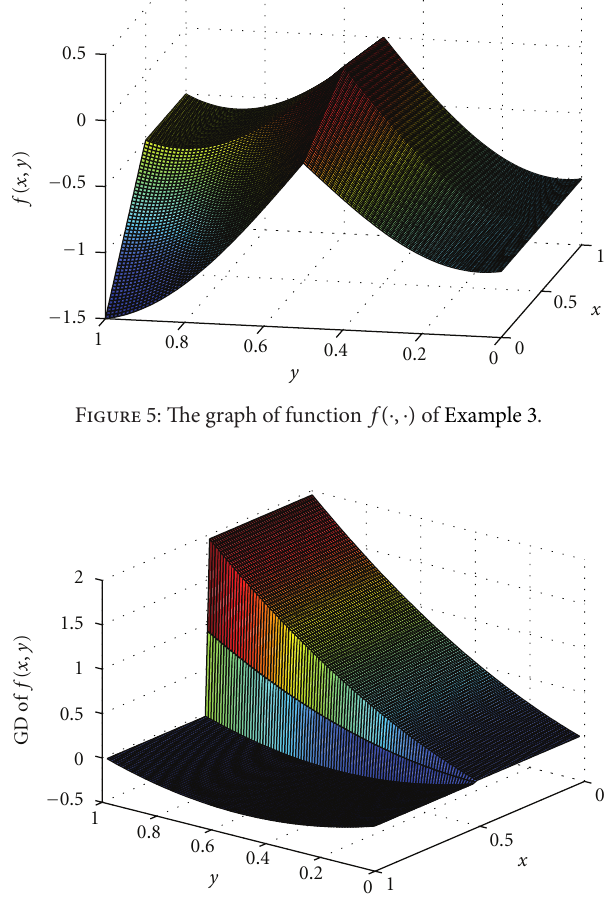
Figure 6: The graph of GD of 𝑓(⋅,⋅) with respect to 𝑥 for Example 3.